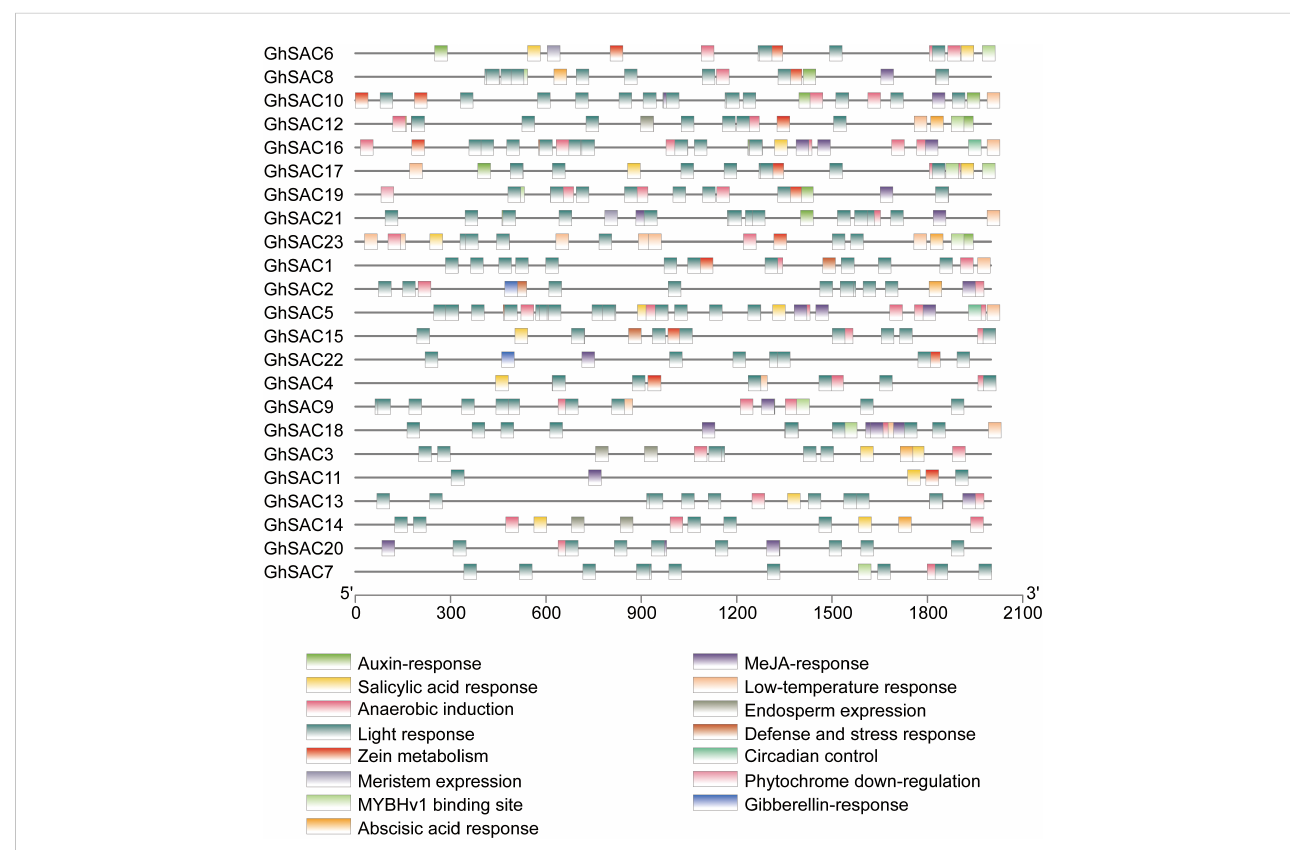
FIGURE 4 Promoter cis -element analysis of GhSAC genes. G. hirsutum SAC genes promoter region (2kb upstream from start codon) was used to explore cis - elements related to plant growth, abiotic stresses, and phytohormonal